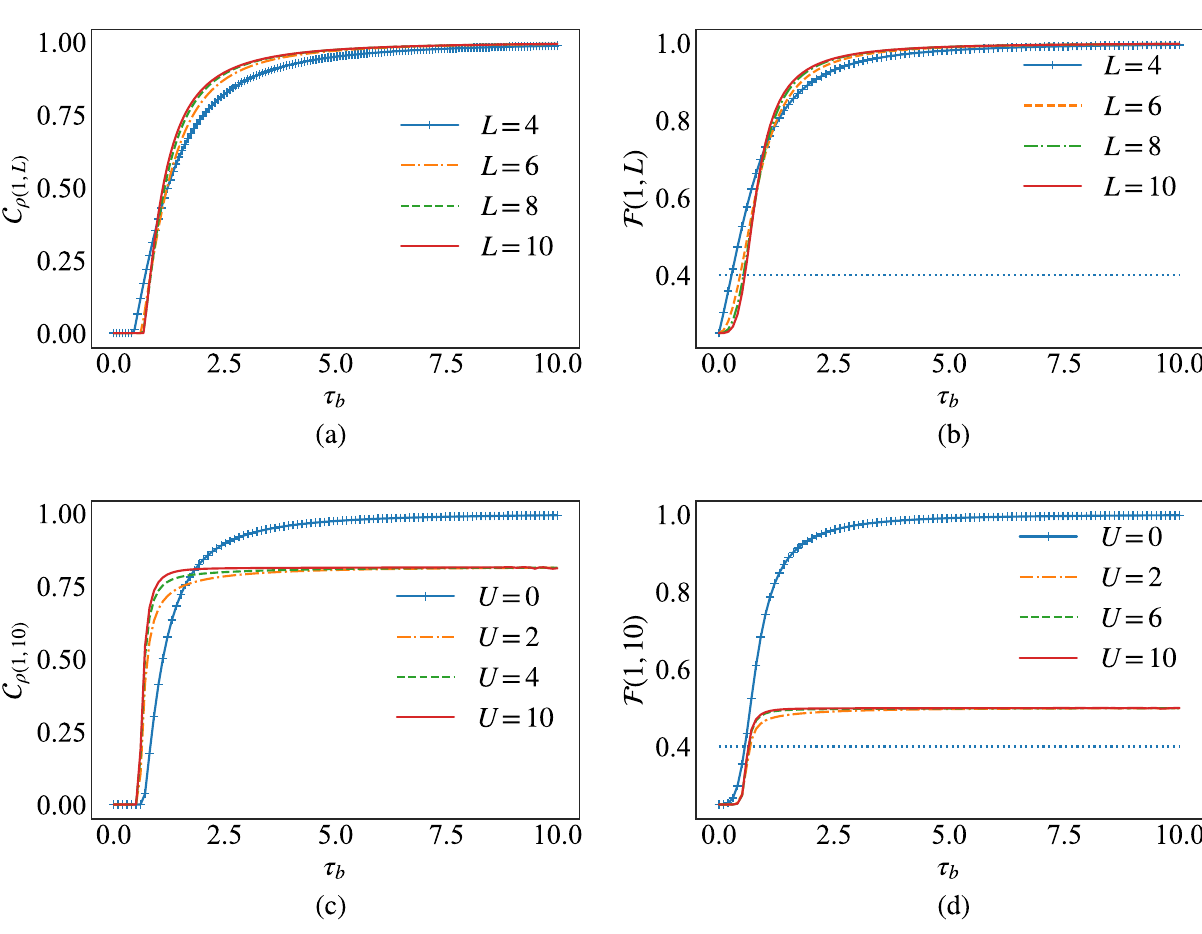
of teleportation which grows more rapidly to 1 while increasing τ b for smaller chain sizes L , as shown in Fig. 5b. The effect of the Coulomb interaction on the end-to-end entanglement for a chain of L Fig. 5c, where we see the threshold value is independent of U when U > 0 . Additionally, the end-to-end concur- rence rise rapidly to 1 for zero Coulomb interaction, while it reaches the asymptotic value of 0.8 for U > 0 . Here again, the fidelity of teleportation follow the behavior of entanglement shown in Fig. 5d for L that the slight reduction in the amount of the entanglement between the ends of the chain due to the Coulomb interaction, translates into large losses in the fidelity of the quantum teleportation. We note here that the Hub- bard projective measurements have been used in the protocol in order to achieve unit fidelity of the quantum teleportation, which in combination with the alternating hopping amplitudes renders the protocol independent of the input state to be teleported (c.f. Figure S2 in the supplementary materials).